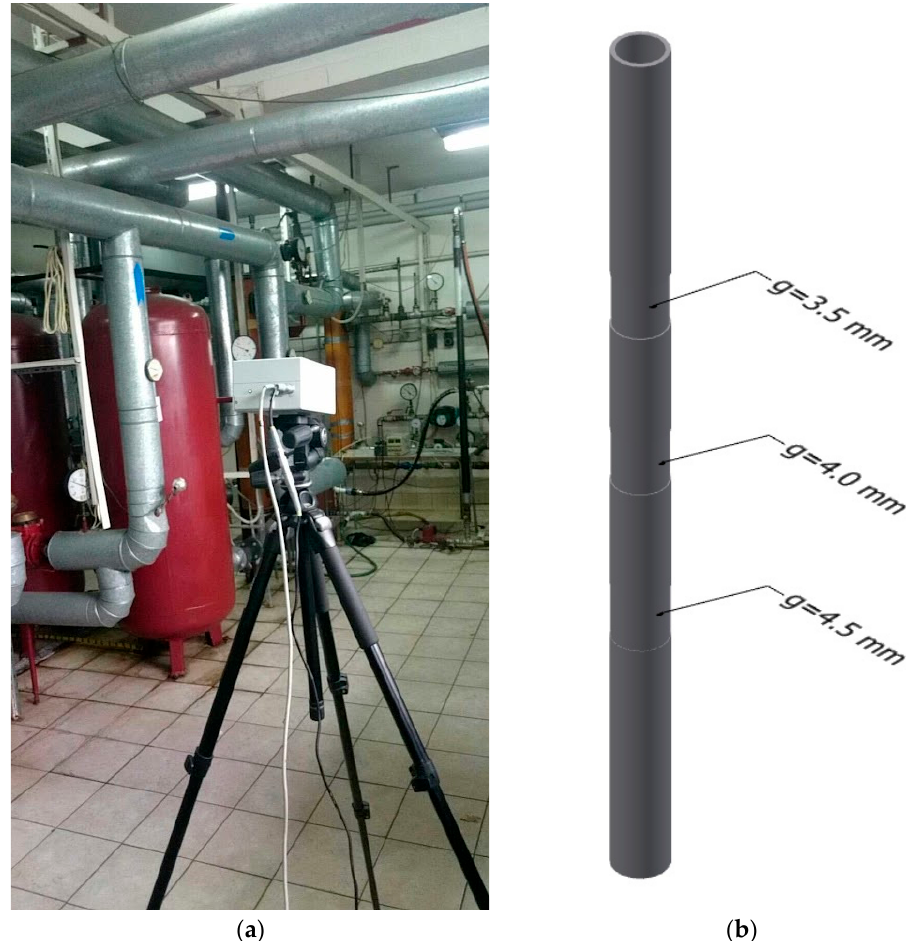
Figure 4. ( a ) Photo of the measuring stand using active thermography, ( b ) vertical pipe with a wall thickness of g = 5 mm, with narrowed regions marked.